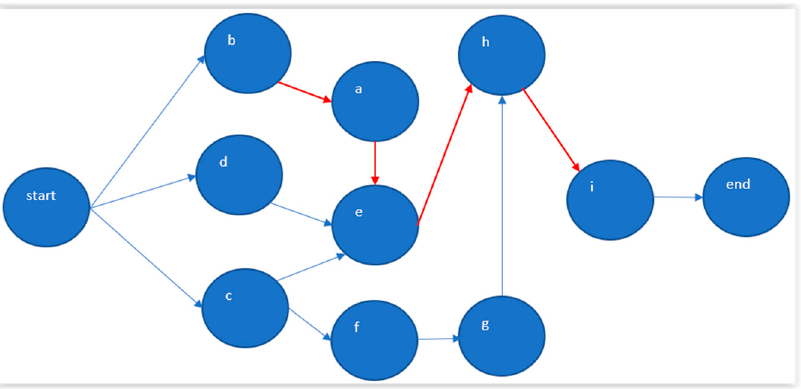
Figure 7. Critical path for attitudes towards the event of Croatia’s accession to the EU and its fully-fledged membership.